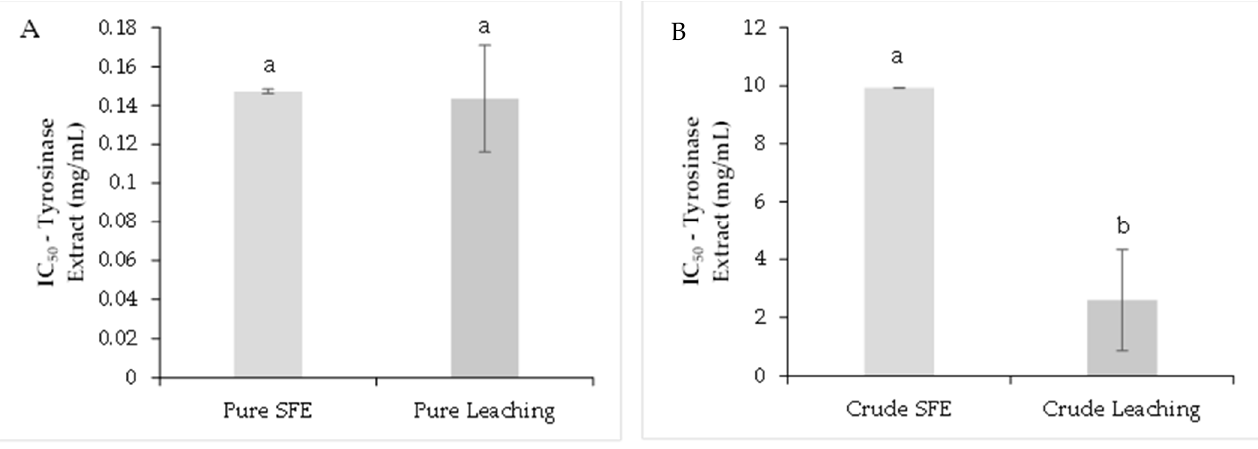
Figure 3. Tyrosinase inhibition capacity analysis. Purified extracts ( A ), crude extracts ( B ). The results are shown as mean ± standard error. Different letters indicate significant differences among treatments ( p < 0.05) (Tukey’s HSD post hoc anal- ysis).